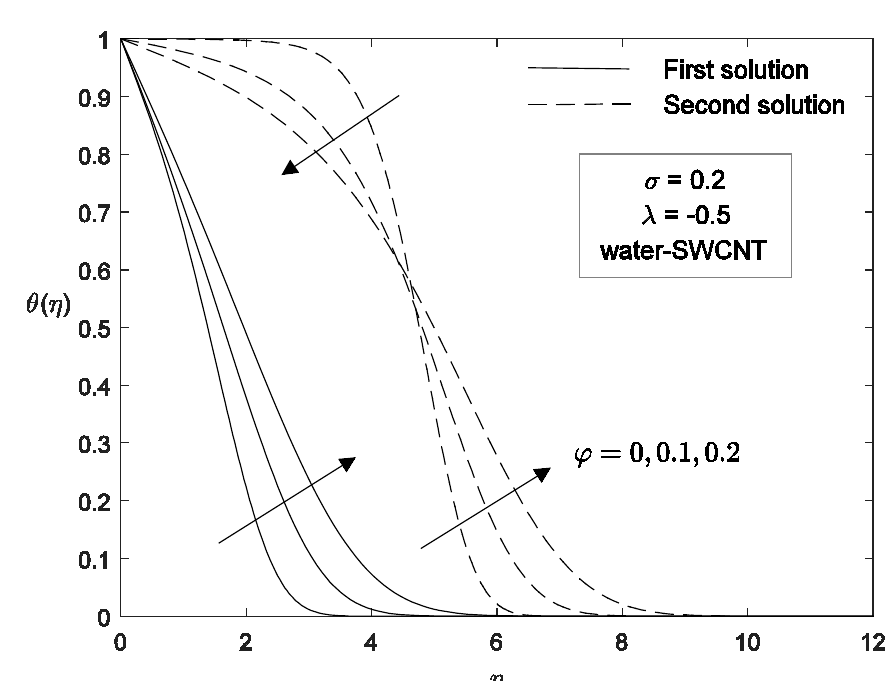
Figure 19. Effect of various ϕ on temperature profile.